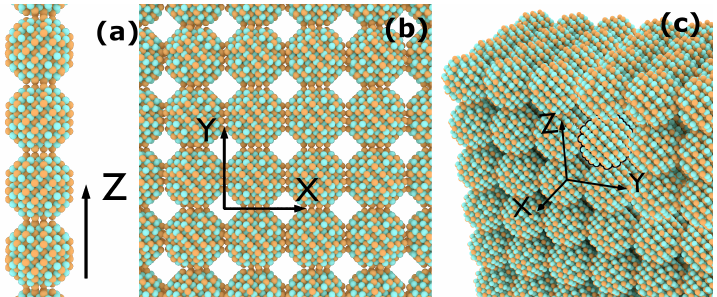
Figure 1. Schematic representation of the simulated CQD arrays in ( a ) 1D, ( b ) 2D and ( c ) 3D. For the sake of clarity, a single quantum dot is highlighted in the 3D structure.